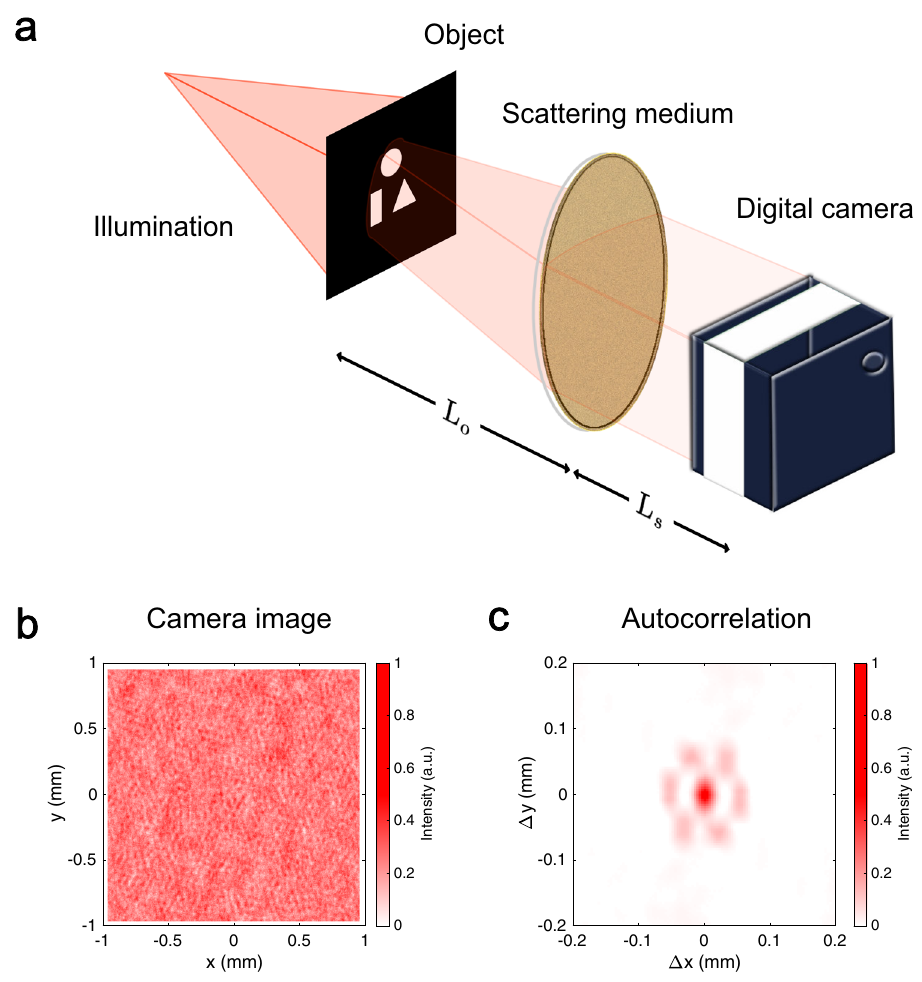
Fig. 1 | Schematic representation ofthe experimentalsetup. a Anobject hidden at a distance L o behind a scattering medium emits light (e.g. because it is illumi- nated).Thescatteredlightformsaspecklepattern,whichisdetectedbyacameraat